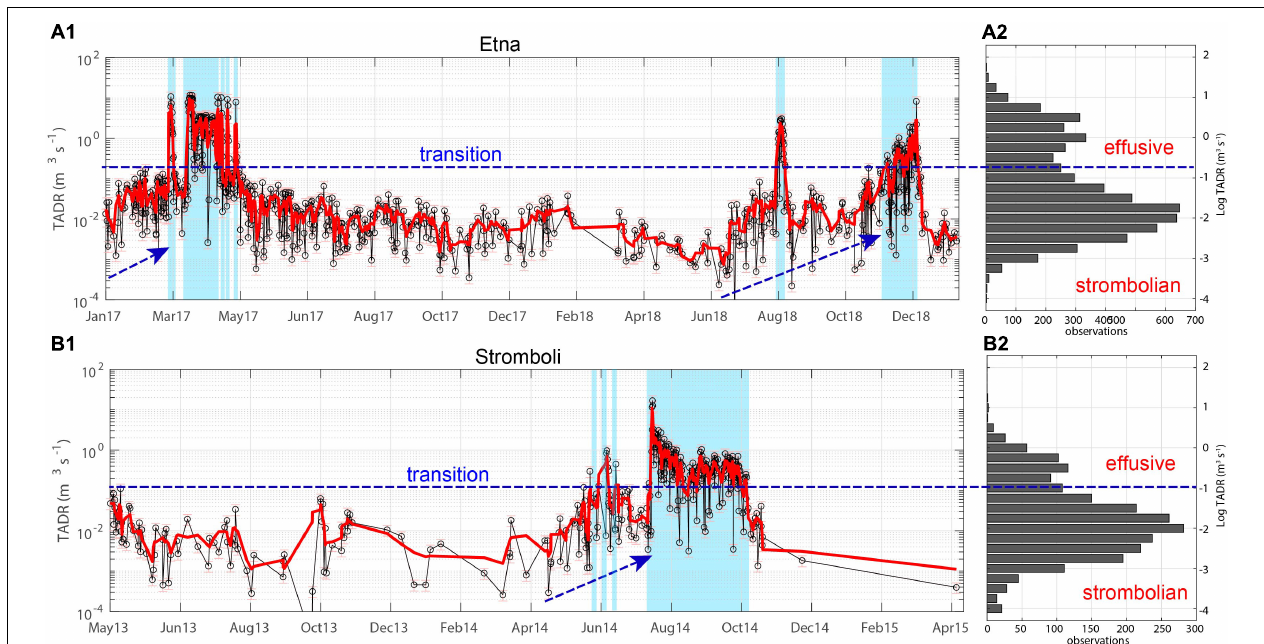
FIGURE 10 | Two-years long time-series of MIROVA-derived TADR for Etna (A1) and Stromboli (B1) volcanoes (modified from Valade et al., 2016 and Laiolo et al., 2019, respectively). A threshold separating the Strombolian and the effusive regime, is calculated from the statistical analysis of log-transformed TADRs (A2,B2) that outline the bimodal behaviors of magma